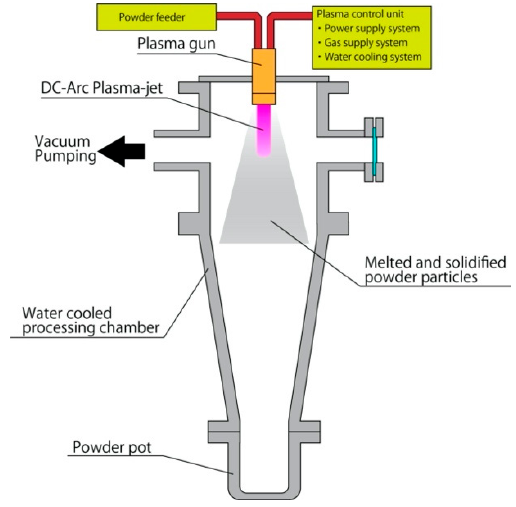
Figure 1. Schematic view of DC arc plasma processing system.